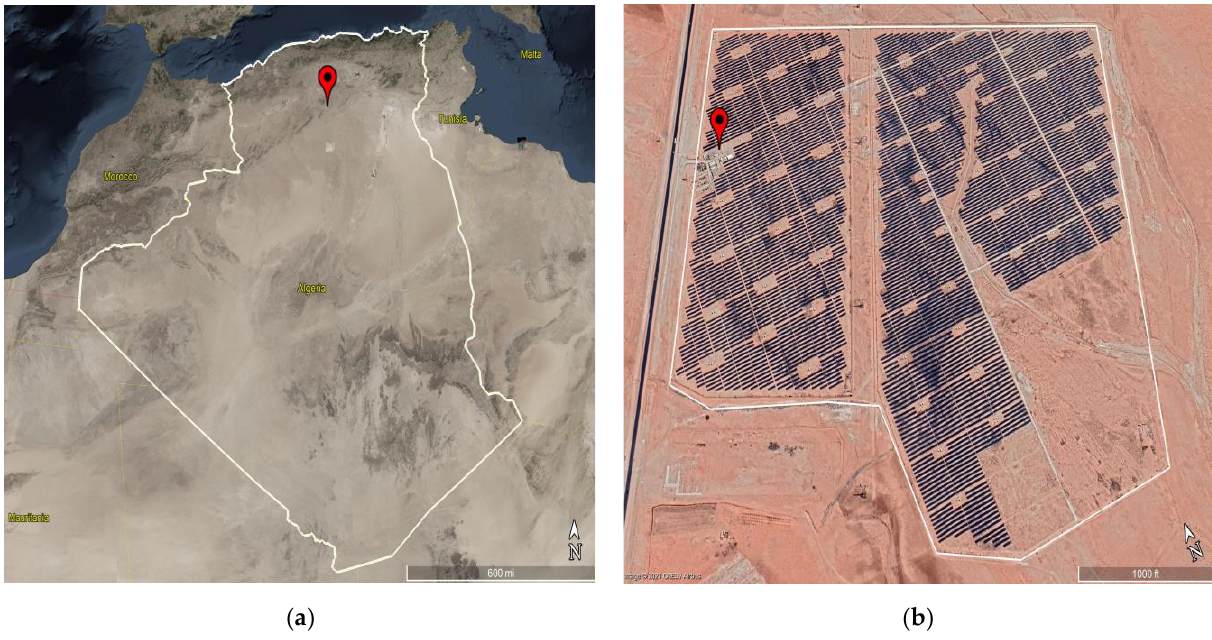
Figure 3. The geographical map of the study location using Google Earth. ( a ) Map of the selected location; ( b ) close look at the selected location. Table 2. Geographical coordinates of the study